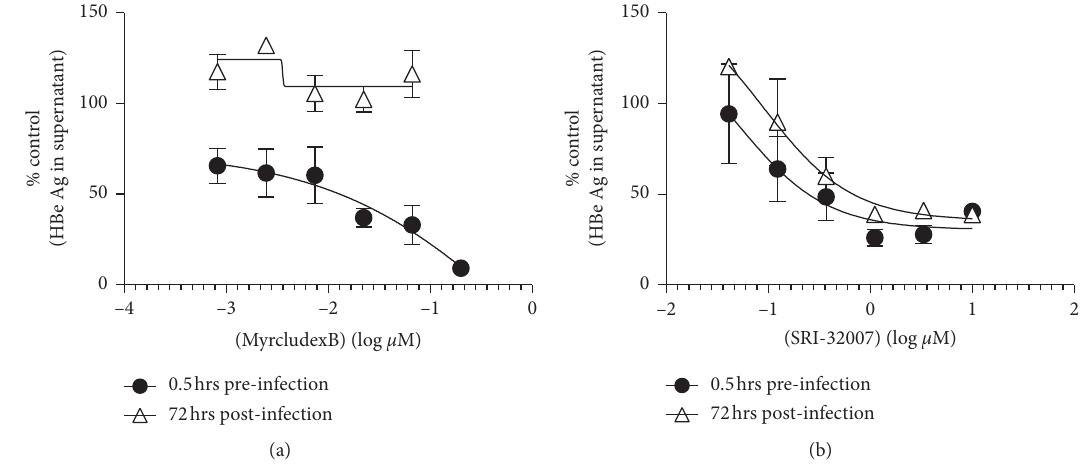
Figure 3: Activity of SRI-32007 in the HBV infectious virus assay in HepG2-NTCP cells. HepG2-NTCP cells were treated with different concentrations of Myrcludex B (a) and SRI-32007 (b) either 0.5 hours before infection or 72 hours postinfection with HBV. HBe Ag levels (mean ± standard deviation) in the culture supernatant as measured by ELISA seven days postinfection normalized to the untreated virus controls are shown in the